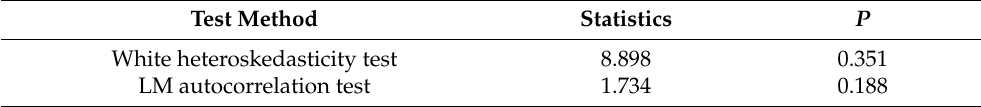
Table 2. Heteroskedasticity and autocorrelation test results.